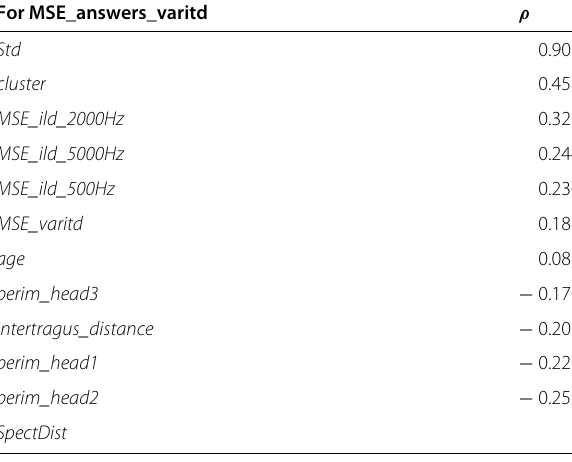
Table 2 Spearman rank correlation coefficients between MSE_answers_varitd and the rest of